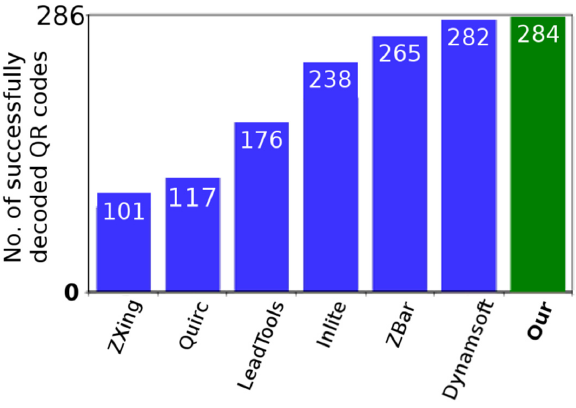
Figure 21. Our results compared with competitive solutions.